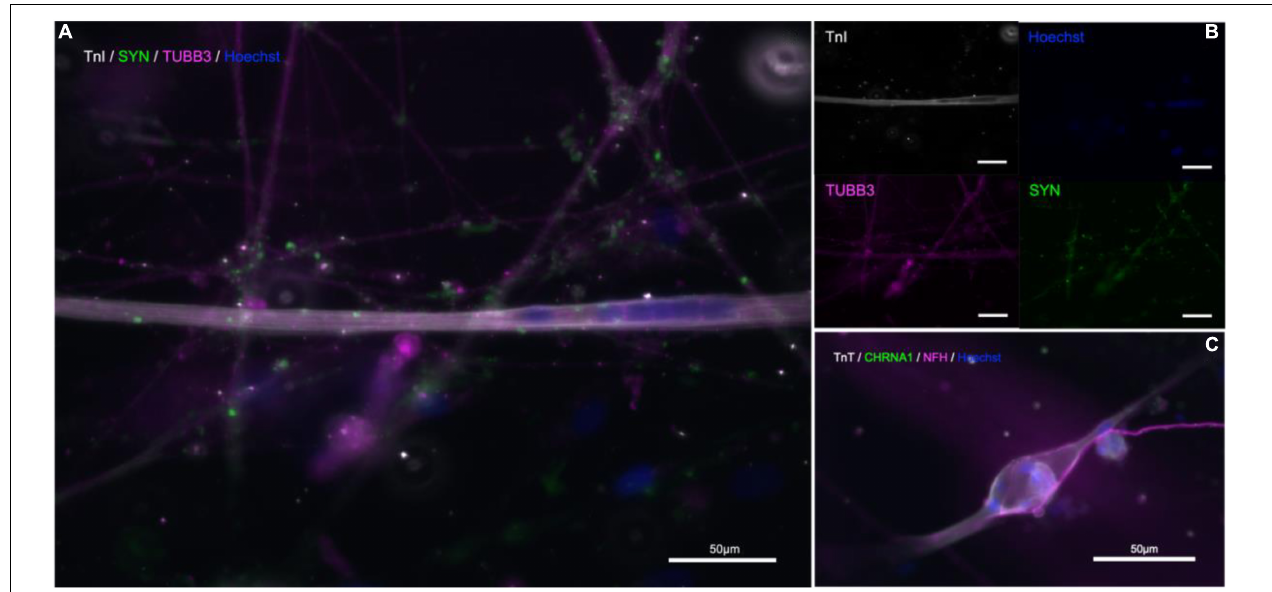
FIGURE 5 | Immunostaining in microfluidic chips indicates presence of NMJs. (A,B) Troponin I (TnI, gray), synaptophysin (SYP, green), and β -III-tubulin (TUBB3, magenta), nuclear stain Hoechst (blue). (C) Neurofilament-heavy (NF-H, magenta), nicotinic acetylcholine receptor subunit 1 (CHRNA1, green), troponin T (TnT, gray), nuclear stain Hoechst (blue).